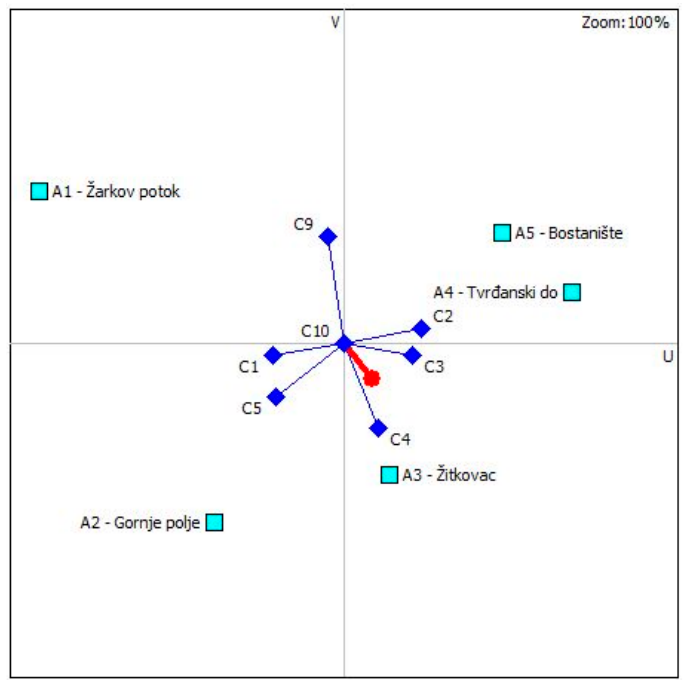
Figure 5. GAIA plan for tailing ponds.